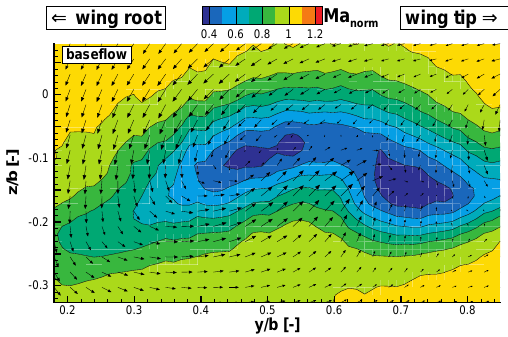
Figure 23. Wake flow at ( α max , base + 2.3 ◦ ) for the base flow.